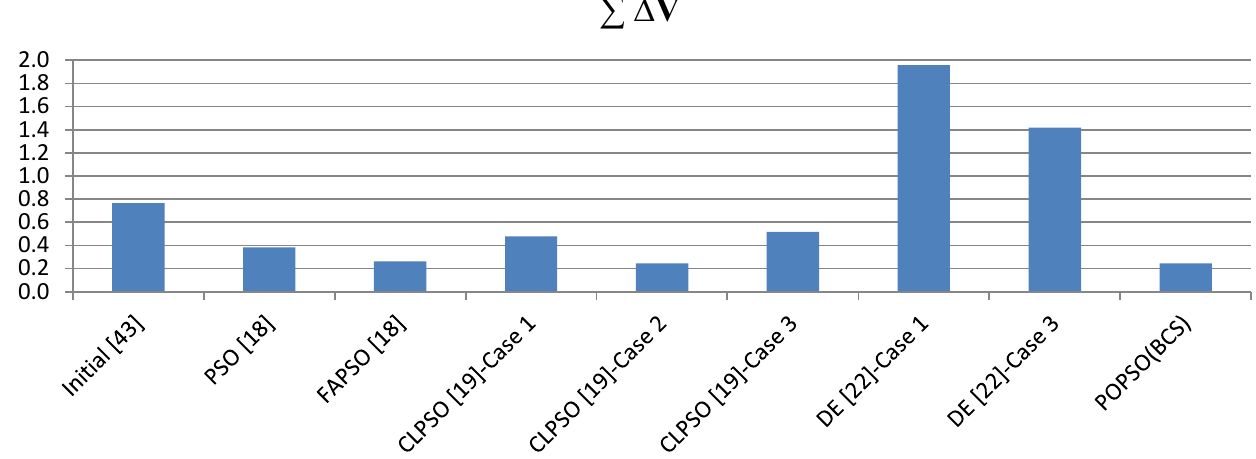
Figure 10. Comparison results of voltage deviation in IEEE 30-bus test